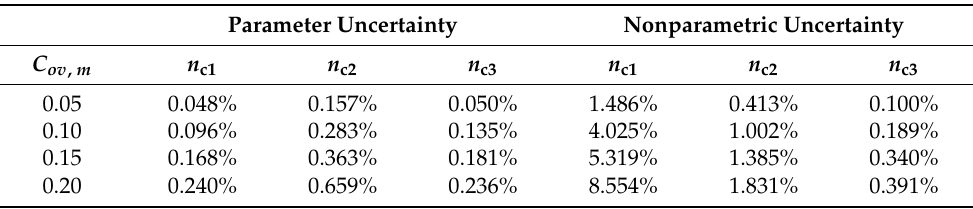
Figure 7. The first three ‐ order critical speeds of the uncertain dual ‐ rotor system for C ov , m , from 0 to 0.20. ( a ) The first ‐ order critical speed. ( b ) The second ‐ order critical speed. ( c ) The third ‐ order critical speed. Table 3. Relative errors of the first three ‐ order critical speeds of a system with two uncertainties at the disk ‐ shaft element.